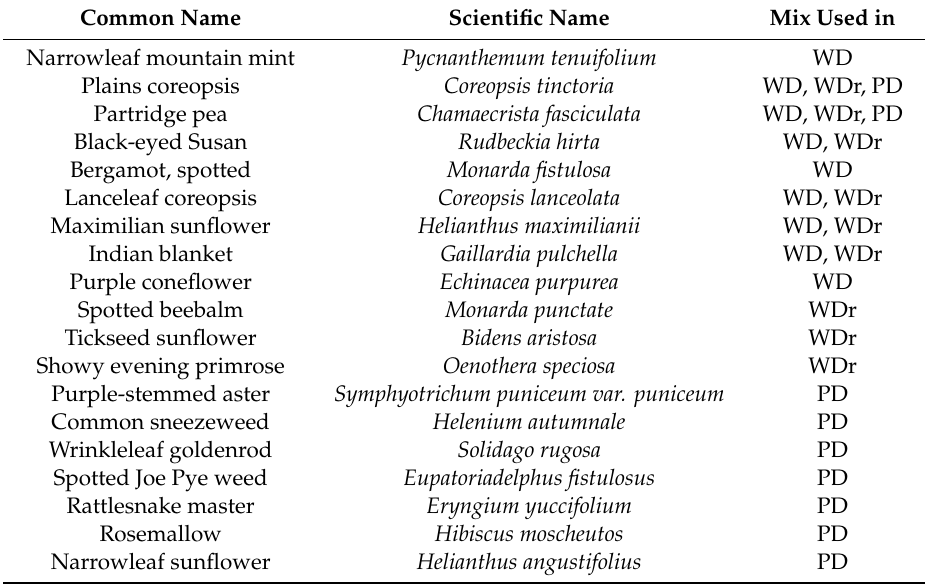
Table 1. Wildflower species used in well-draining soils (WD), well-draining replacement (WDr), and poorly draining soils (PD) seed mixes. For WD, WDr, and PD, n = 7, 1, and 2,